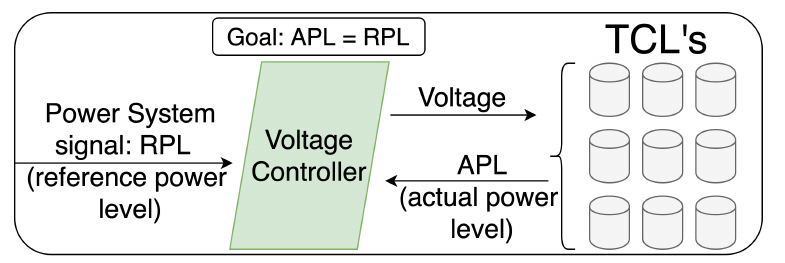
Figure 1. High-level overview of a problem